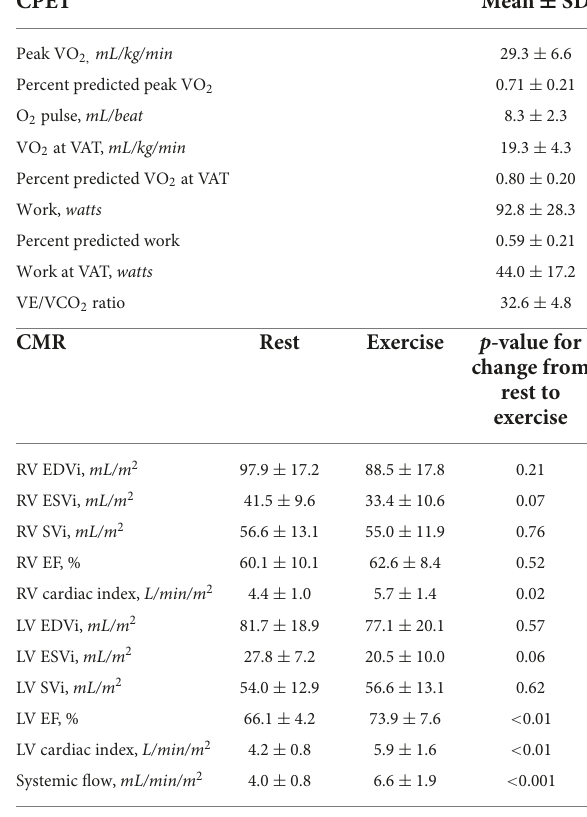
TABLE 3 Exercise performance